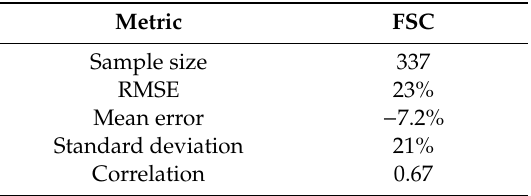
Table 8. Evaluation of the Sentinel-2 FSC against the ODK data.